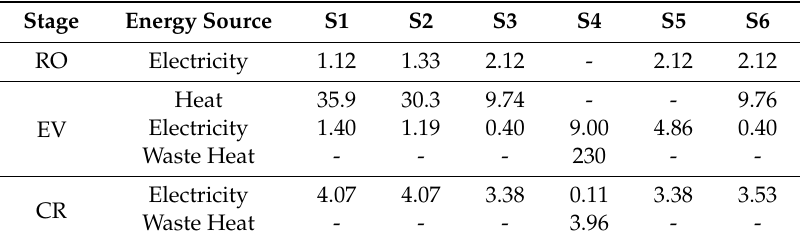
Table 4. Total energy consumption per stage of the system for each scenario (in MJ/RF). RO: reverse osmosis; EV: evaporation; CR: